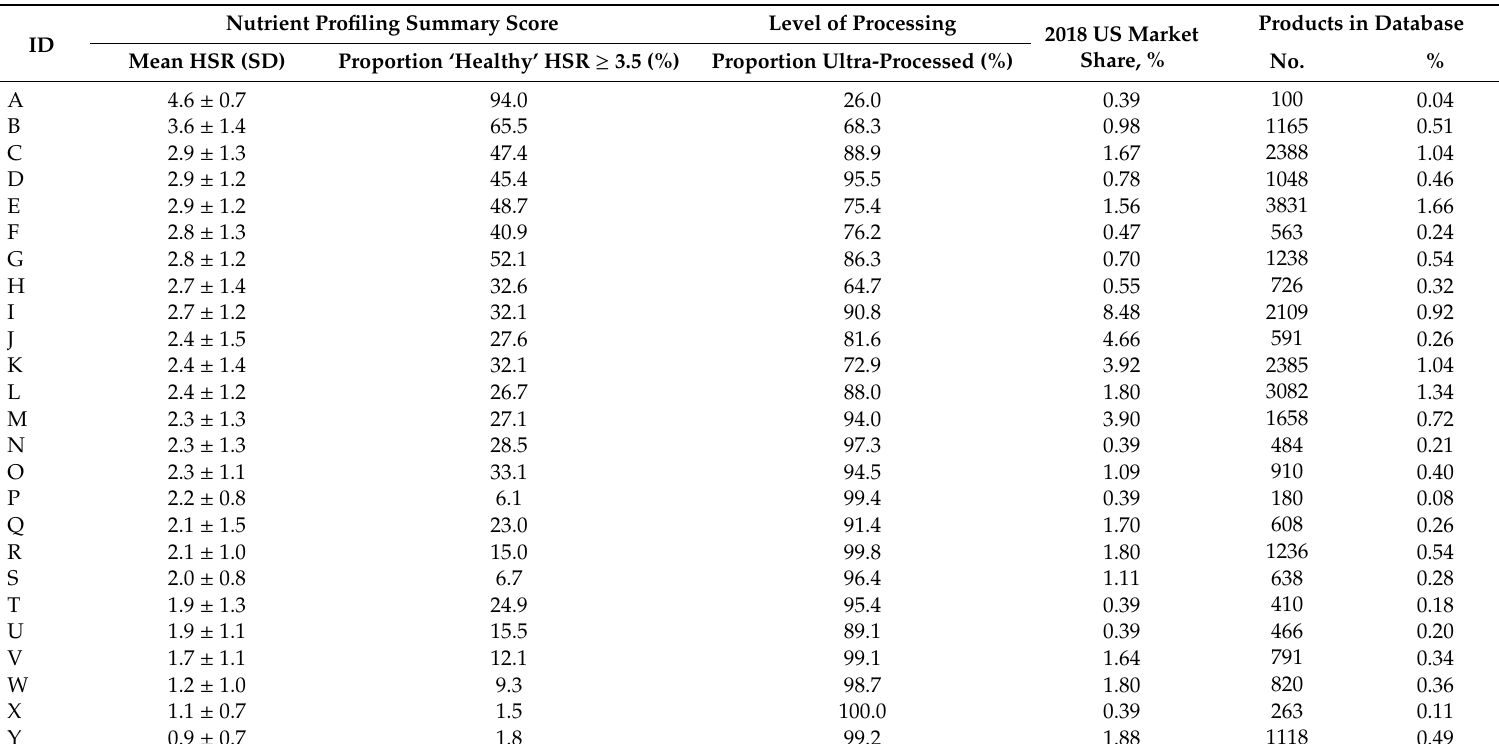
Table 3. Healthfulness of the US food and beverage supply among the top 25 manufacturers, based on 2018 retail